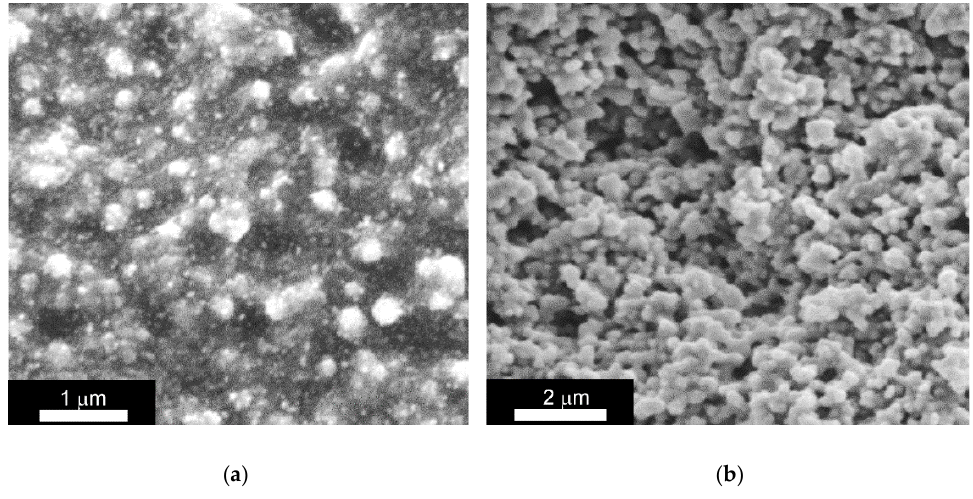
Figure 8. Scanning electron microscopy data for composite elastomers ( a ) ERE-0 and ( b ) ERE-5 after analysis of the degree of crosslinking of the polymer matrix (after washing in toluene and ethanol).